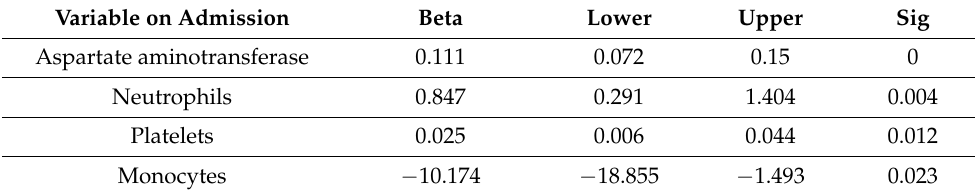
Table 2. Regression model for CT scan severity score at peak of infection. Variable on